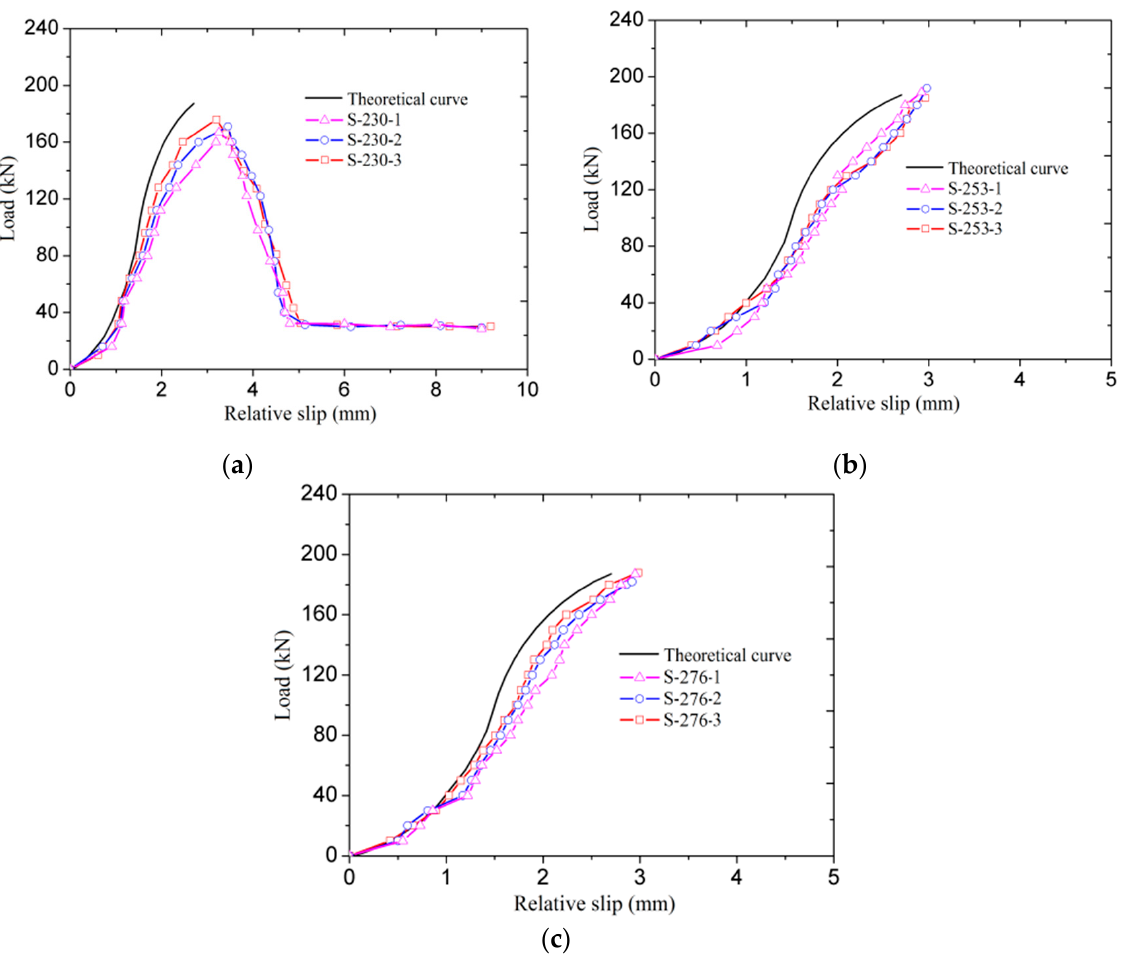
Figure 13. Experimental and theoretical load-slip curves of the specimens: ( a ) Group 1; ( b) Group 2; and ( c ) Group 3. With a deep comparison between the tested results and the theoretical results, alt- hough there are differences, they are matched well and thus the effectiveness of the pro- posed connection system and the derived design formulas are both verified. For the BFRP bars spliced in the present study, a minimum correction factor of 1.1 should be adopted in connection system design. Whereas it should be noted that designing the resin-filled GFRP pipe connection system for splicing FRP bars is beyond the scope of the present study, external experimental tests should be conducted to determine the correction factor for determining the final GFRP pipe length. 4. Conclusions A new resin-filled GFRP pipe connection system was proposed for the butt splicing of FRP bars. With the proposed connection system and a simplified trilinear interfacial bond-slip model, a set of design formulas were derived based on the requirement that the proposed connection system should provide a load transfer capacity beyond the tensile capacity of the spliced FRP bars. At last, to evaluate the effectiveness of the proposed con- nection system and the derived design formulas, nine specimens were fabricated and tested under unidirectional tension to study their tensile performance. Based on the com- parison between the theoretical and experimental results, the following conclusions can be drawn: • Bond-type connection system is able to connect symmetrically placed FRP bars for splicing application. The proposed resin-filled GFRP pipe connection system can pro- vide a sound connection and simple mechanism for the butt splicing of the BFRP bars studied herein.